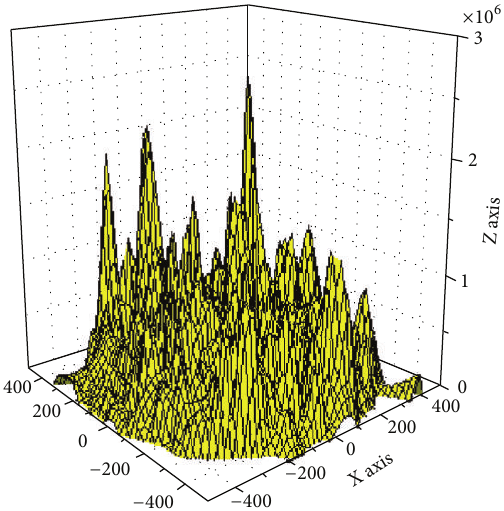
Figure 19: Energy consumption of randomly deployed network.